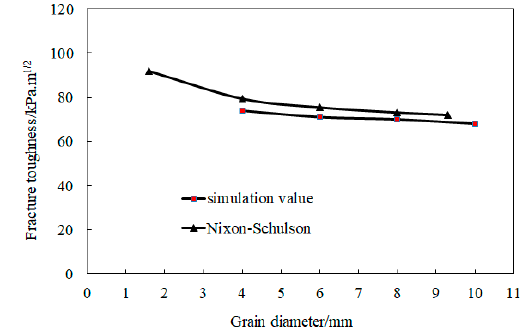
Figure 8. Contrast diagram of simulated values and literature values of fracture toughness for different grain sizes.